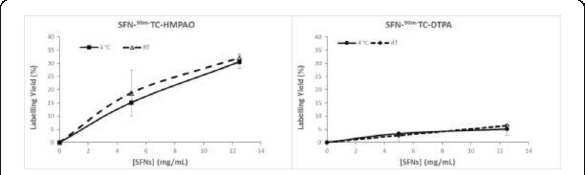
Fig. 1 (abstract PP06). See text for description. *RT=Room temperature, n =